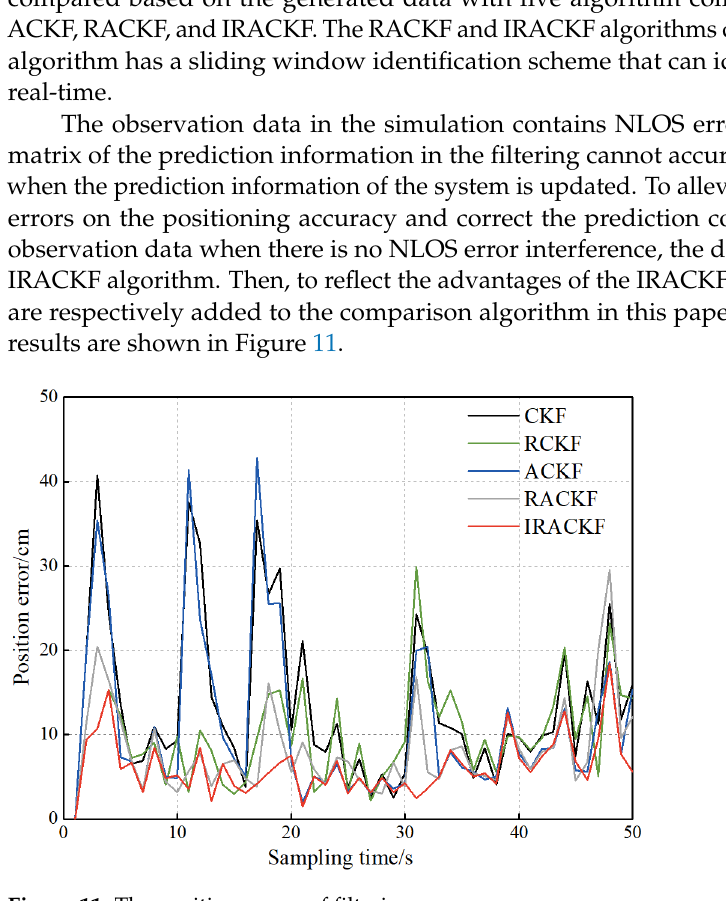
Figure 11. The position errors of filtering.